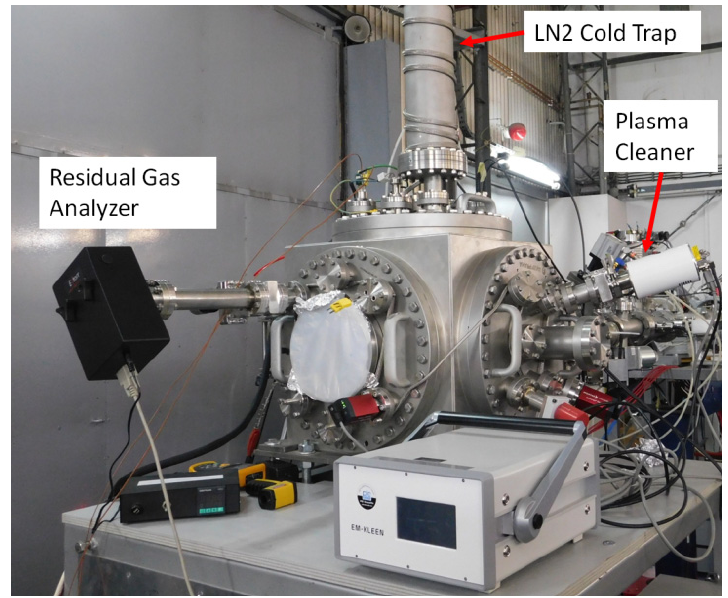
Figure 9. DiFU chamber with LN2 cold trap, TECTRA ExTorr Residual Gas Analyzer, and EM-KLEEN Plasma Cleaner.